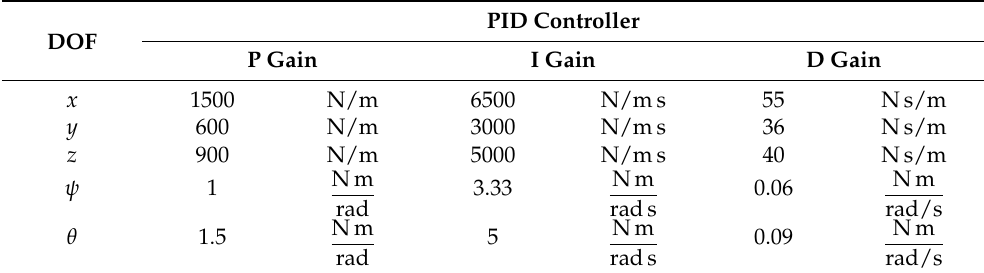
Table 5. Five-DOF PID controller